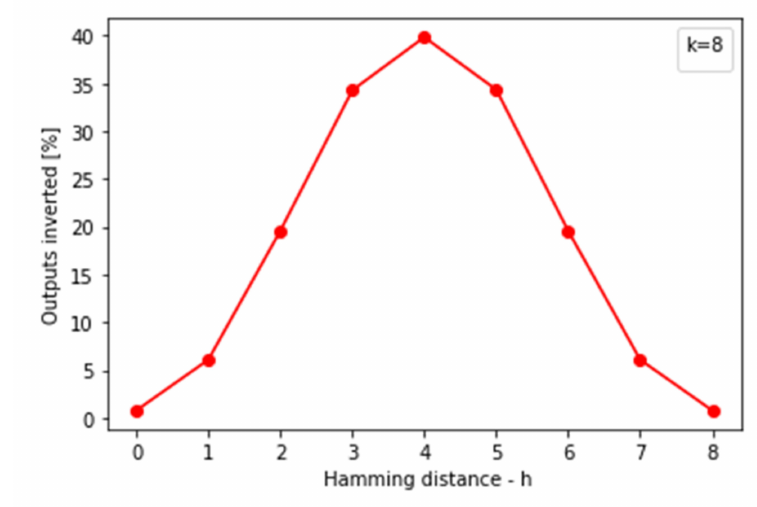
Figure 19. Corruptibility of outputs.